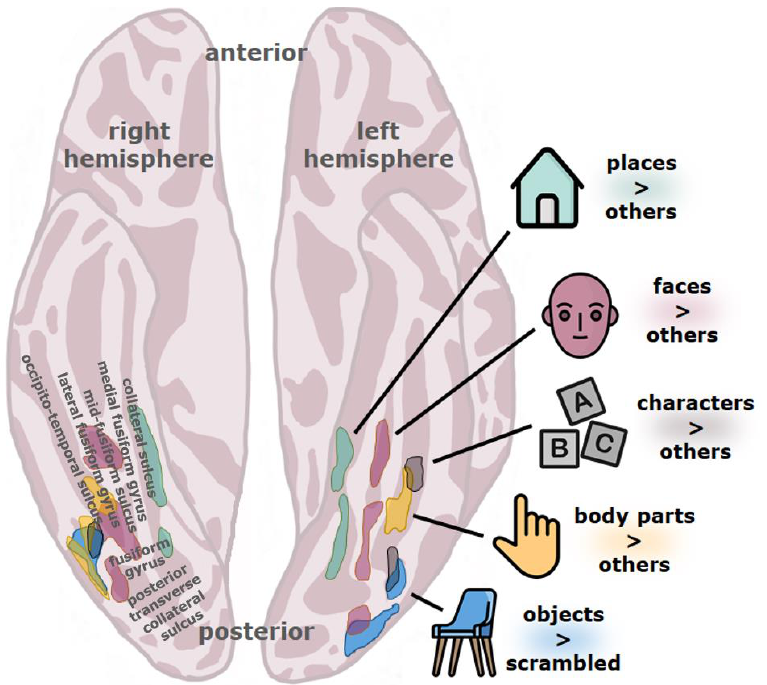
Figure 2. Topographical organization of the high-level ventral visual stream. Regions are defined by contrasting the activity evoked by a category with activity evoked by other stimuli, represented by >. Place-selective regions (cyan) are defined by places > (faces, characters, body parts, objects), face-selective regions (mauve) by faces > (places, characters, body parts, objects), character-selective regions (grey) by characters > (places, faces, body parts, objects), body part-selective regions (yel- low) by body parts > (places, faces, characters, objects), and object-selective regions (blue) by objects > scrambled objects (which share low-level visual qualities with objects). Character-selective regions tend to be found within the occipito-temporal sulcus. They partially overlap with face-selective, body part-selective, and object-selective regions. The visual word form area (VWFA), as tradition- ally defined, corresponds to the posterior character-selective area of the left hemisphere. Figure adapted from Grill-Spector and Weiner [37] with author permission. Icons by Flaticon.com. Visual stimuli used to define functional regions can be found at: https://github.com/VPNL/fLoc (accessed on 20 September 2021).